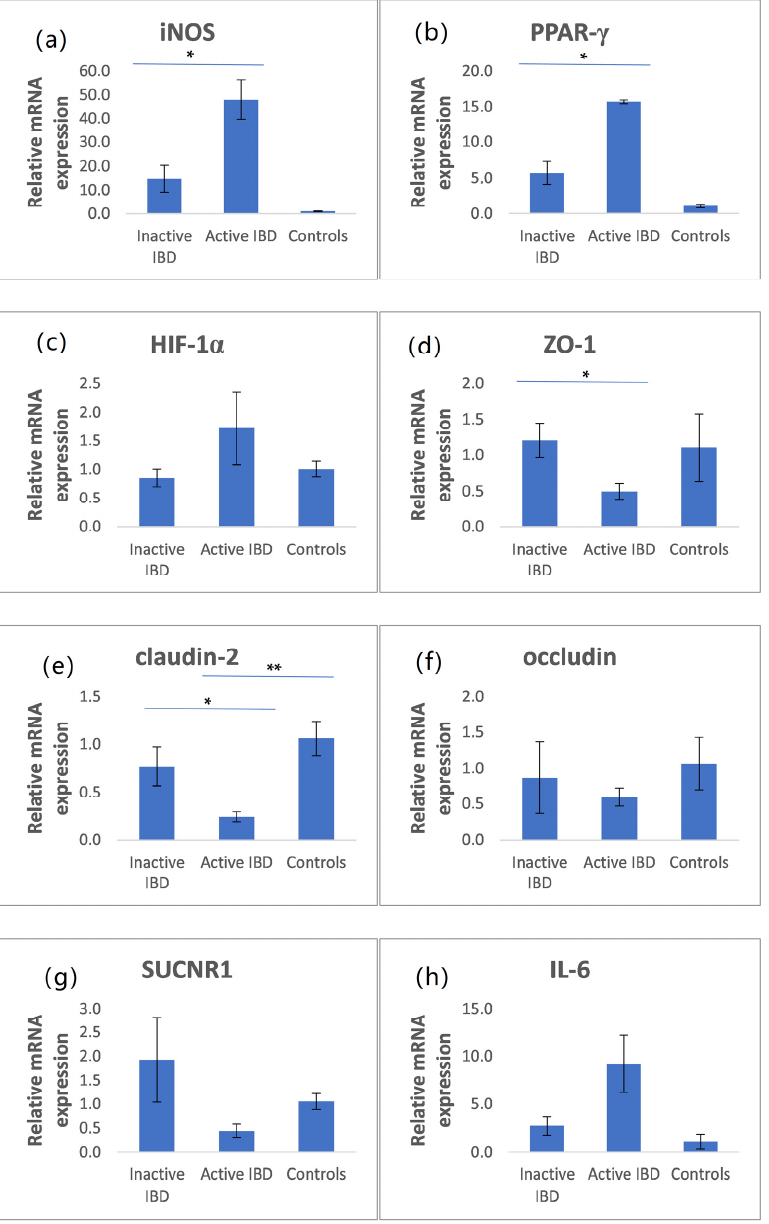
Figure 1. Relative mRNA expression of inducible nitric oxide synthase (iNOS), peroxisome proliferator-activated receptor γ (PPAR- γ ), hypoxia-inducible factor 1 α (HIF-1 α ), zonula occludens-1 (ZO-1), claudin-2, occludin, SUCNR1, and interleukin IL-6 ( a – h ) in colonic tissue of patients with IBD, active IBD, and controls (mean ± SE). * p < 0.05 ** p <